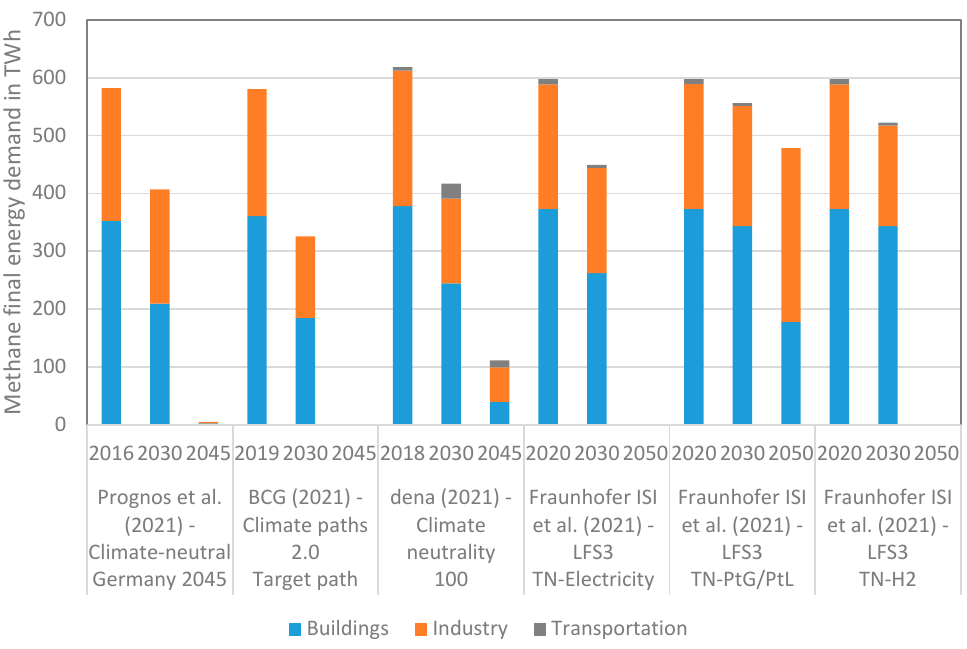
Figure 1. Development of the methane final energy demand in TWh. Authors’ illustration based on [3,9,11,12].